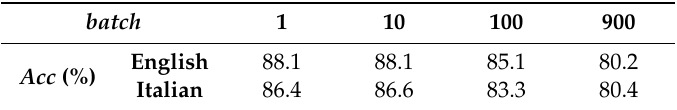
Table 13. Testing accuracy obtained by different batch sizes 1 .